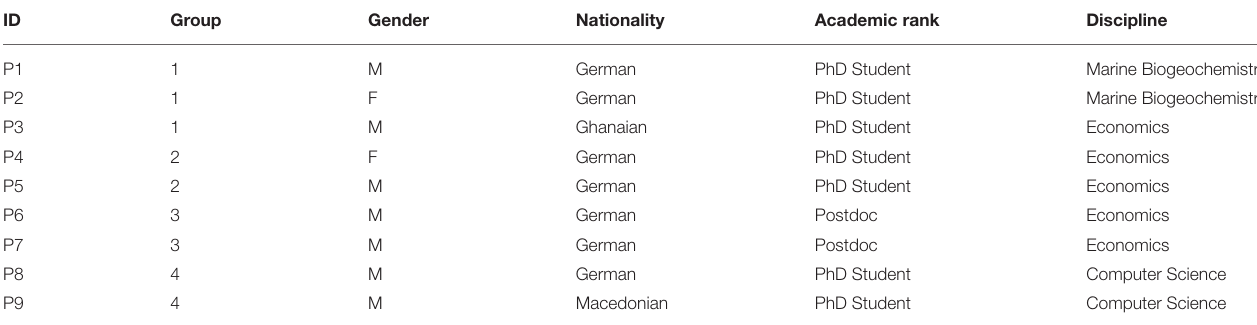
TABLE 1 | Demographic details of interview